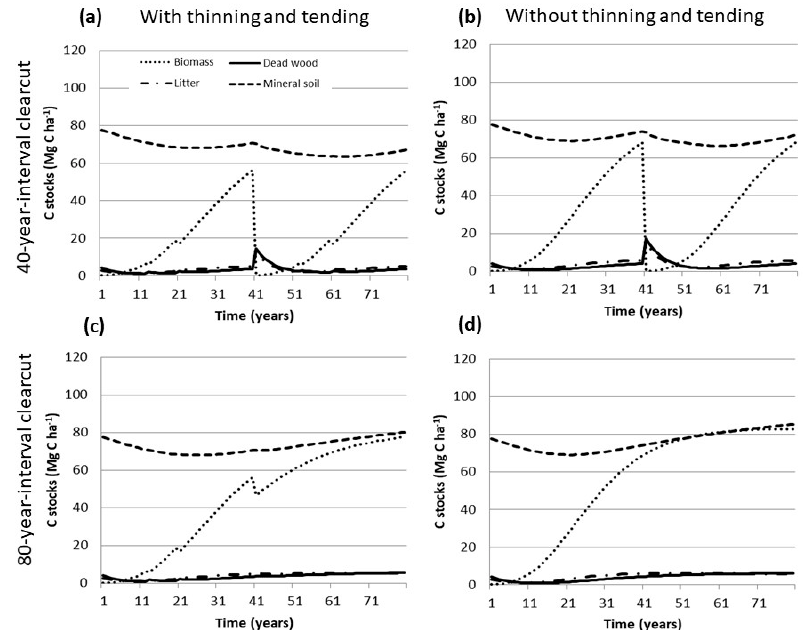
Figure 3. Carbon stock scenarios resulting from the application of the FBDC model for intermediate biomass production forests in South Korea according to ( a , b ) and ( c , d ) cutting age (40 and 80) and ( a , c ) and ( b , d ) with and without thinning and tending during the first 80 years after implementing the forest management. Different line types represent different forest carbon pools (biomass, litter, dead wood, and mineral soil).